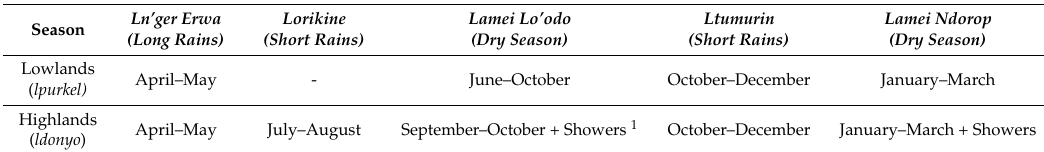
Table 1. Rainfall peaks in the lowlands and highlands of